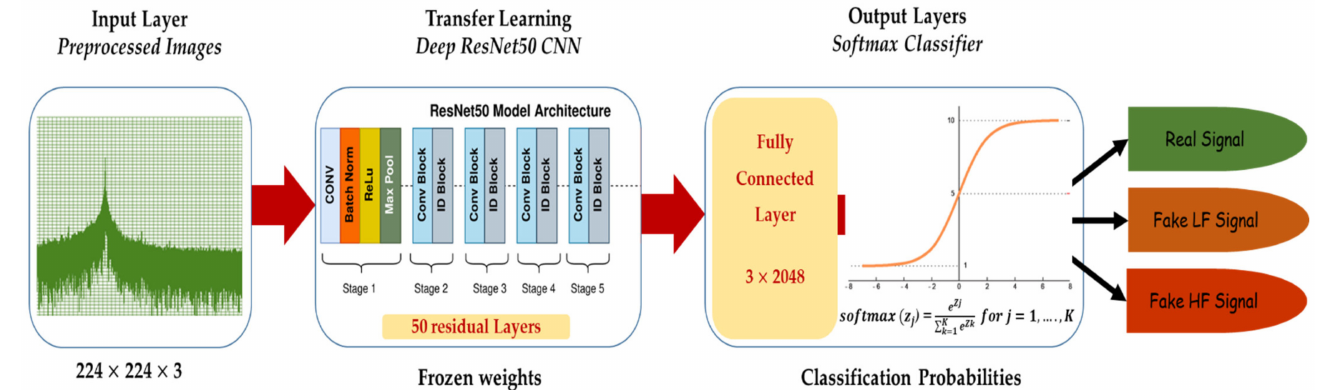
Figure 6. Demonstration of developmental stages of the proposed learning model